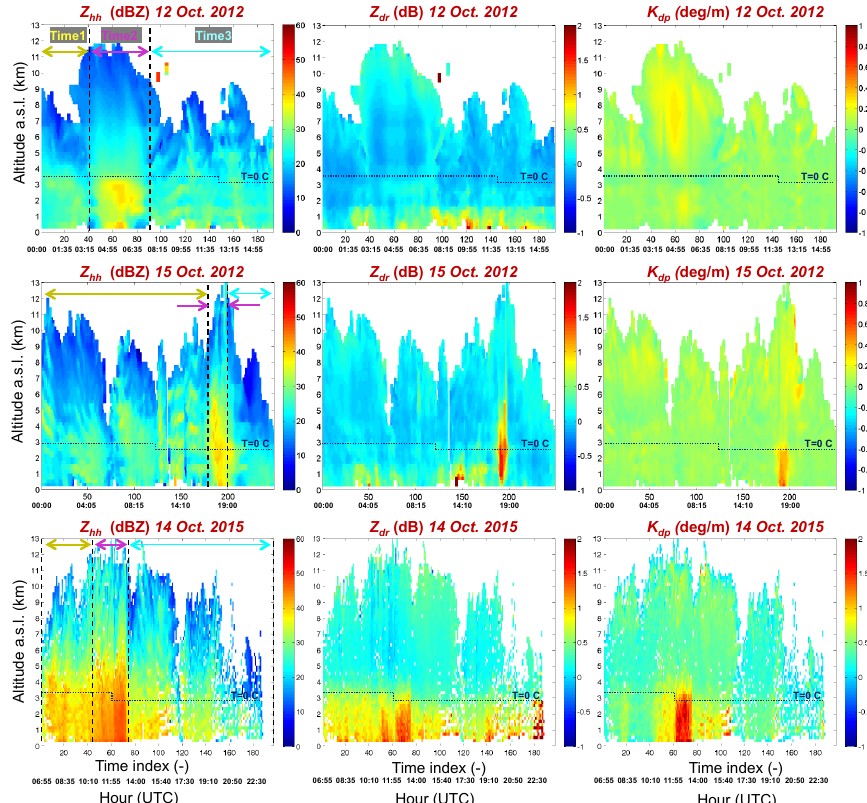
Figure 2. From left to right: time series of quasi vertical profiles of Z hh (dBZ), Z dr (dB), and K dp (deg km − 1 ), respectively, calculated using Equation (5). From top to bottom case studies on 12 October 2012, 15 October 2012 and 14 October 2015, respectively. The horizontal dotted lines indicate the value of zero thermal altitude as registered by the local radiosoundings in Pratica di Mare (id station 16245 LIRE) at 00 UTC and 12 UTC.